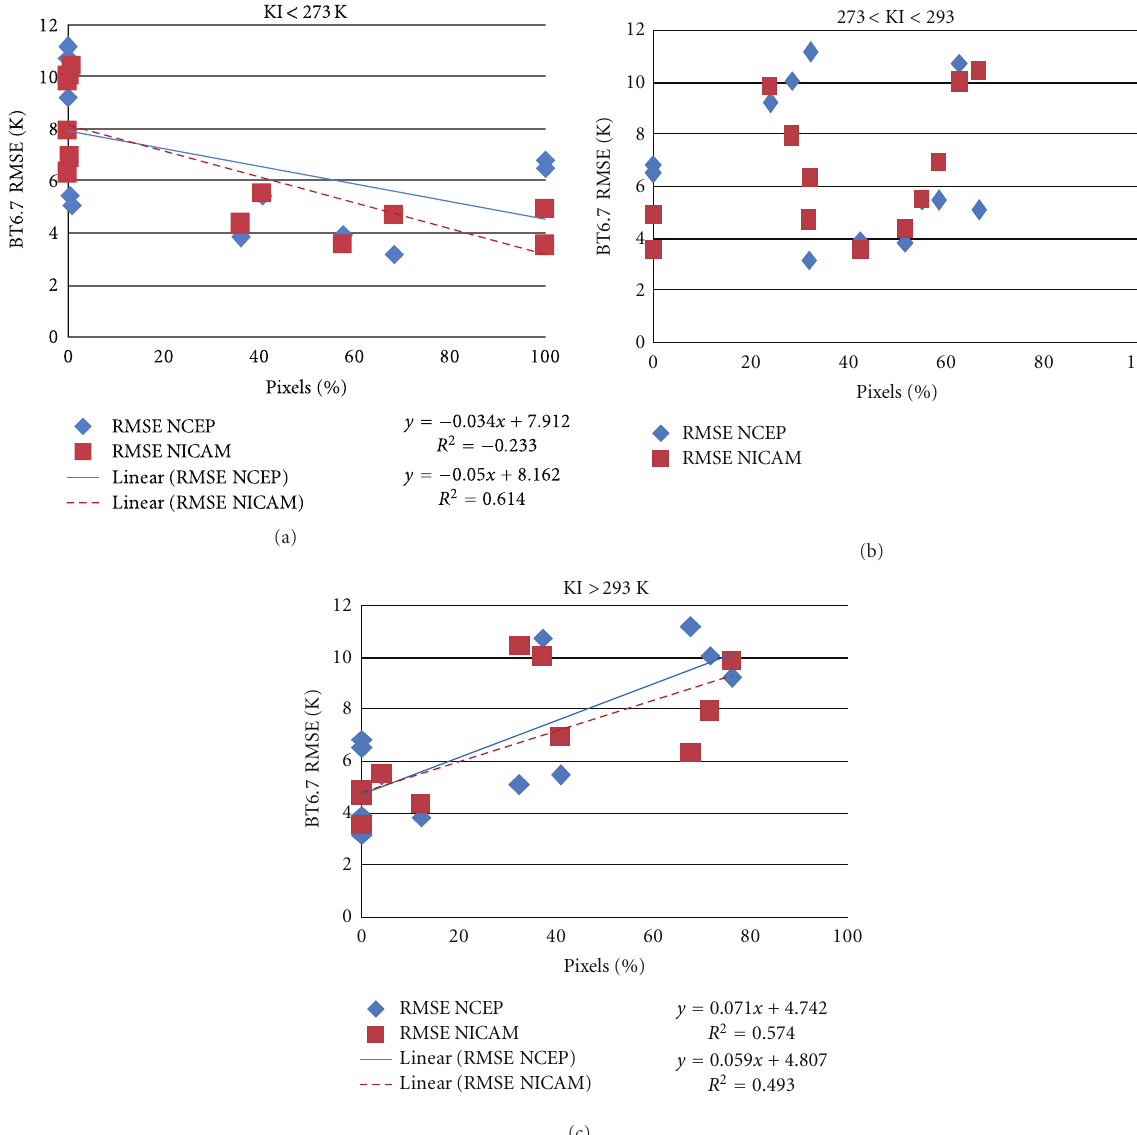
Figure 6: Relationship between clear sky coverage (in %) in each K-index range, with the variation of the brightness temperature at 6.7 μ m wavelength (BT6.7) RMSE (between observations and models). The three classes KI < 0, 0 < KI < 20, and KI > 20 are, respectively, represented by KI < 273K, 273 < KI < 293, and KI >